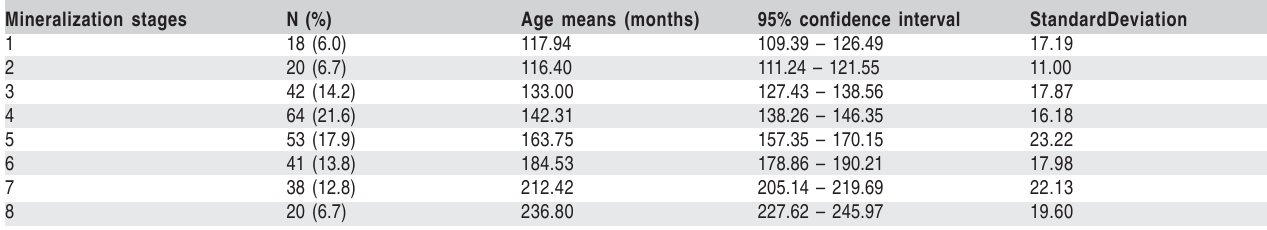
*Data from 296 subjects.